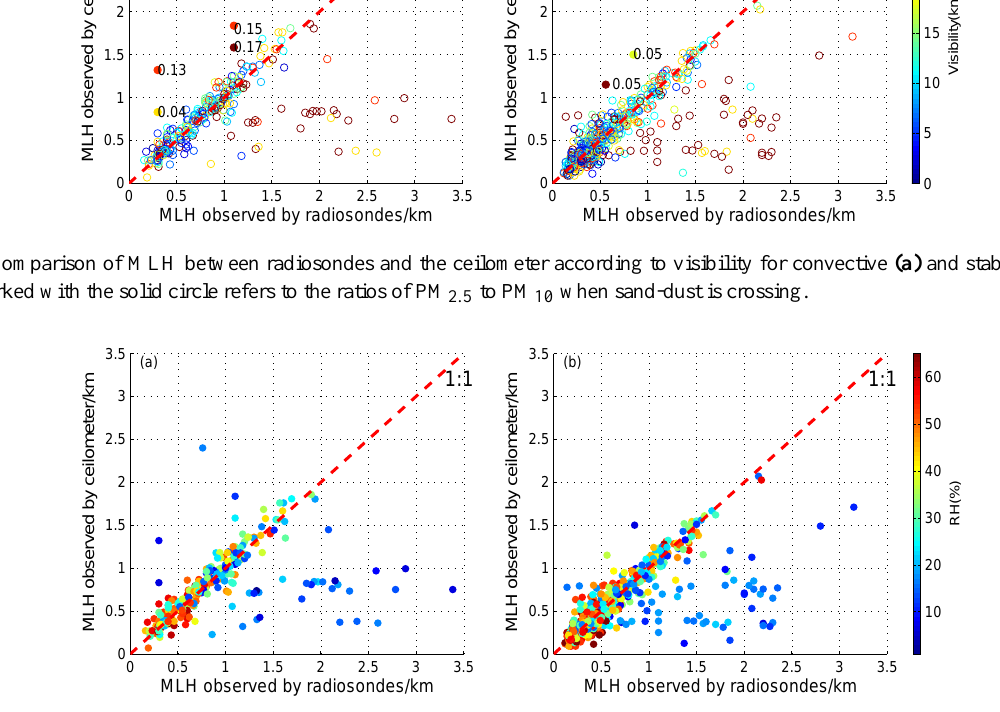
Figure 3. Comparison of MLH between radiosondes and the ceilometer according to RH for convective (a) and stable (b)